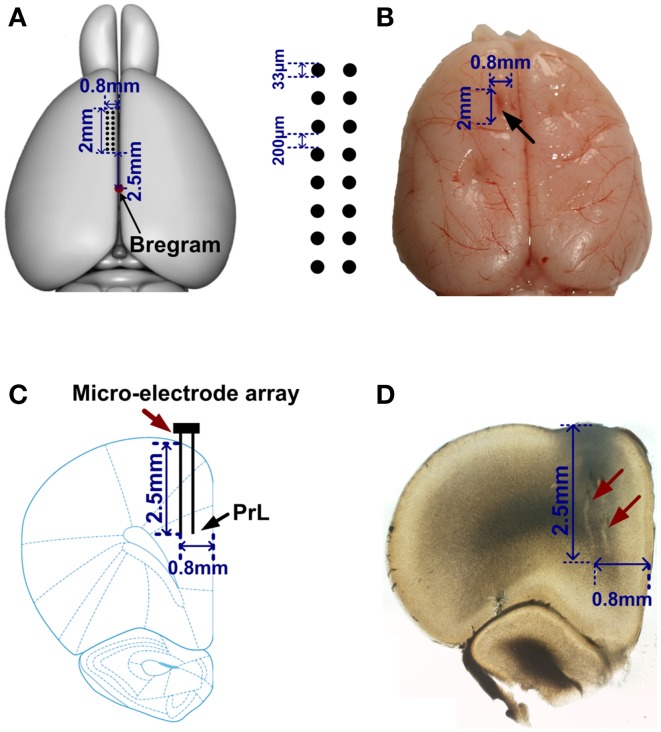
Location of the electrode array in mPFC. (A) Left, a rat brain model (overhead view). Red point indicates the Bregram. 2 × 8 black dots represent a micro-electrode array. (B) A representative photograph of a rat brain. The black arrow illustrates the extent of mPFC lesion after an electrode array was moved through this tissue. (C) A coronal section of a rat brain. An electrode array (red arrow) was implanted in PrL (black arrow). (D) Photomicrograph showing the tracks (red arrows) of recording electrodes.